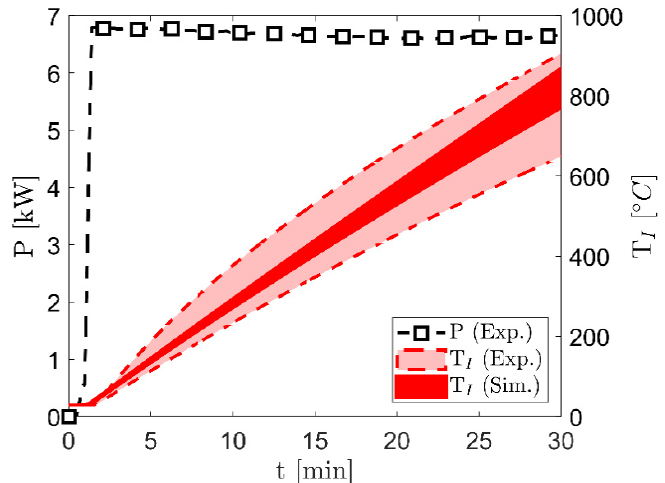
Figure 7. Transient characteristics in the bypass path: outlet temperature (T B − out ) and normalized active cooling mass flow rate ( m B / m B , c ).